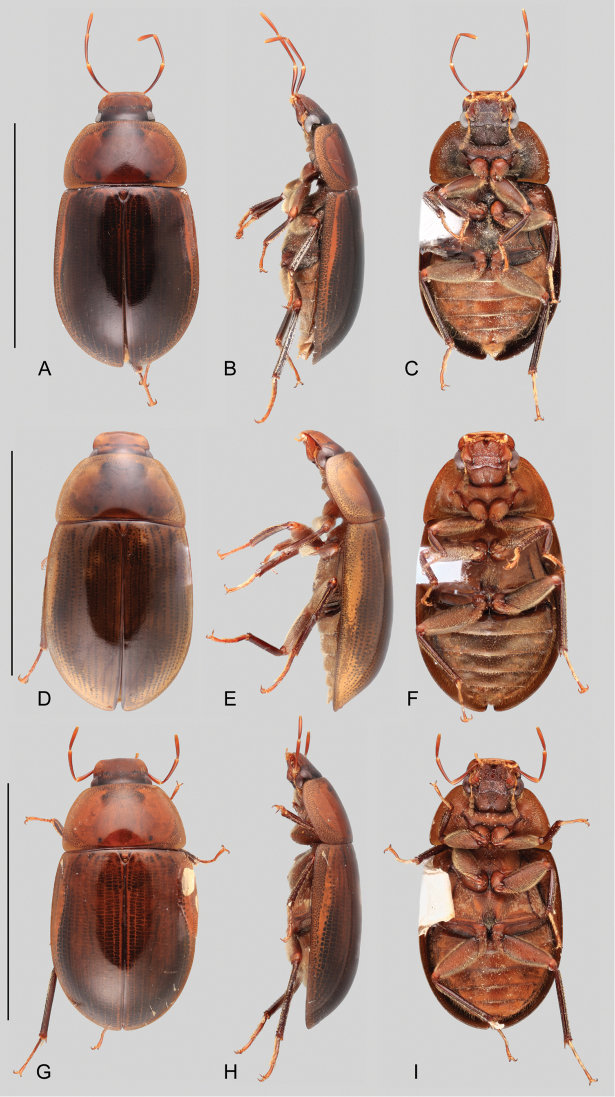
Habitus of Aulonochares spp.: A–CAulonocharestubulus: A dorsal view B lateral view C ventral view. D–FAulonocharesnovoairensis: D dorsal view E lateral view F ventral view. G–IAulonochareslingulatus: G dorsal view H lateral view I ventral view. Scale bars: 5 mm.